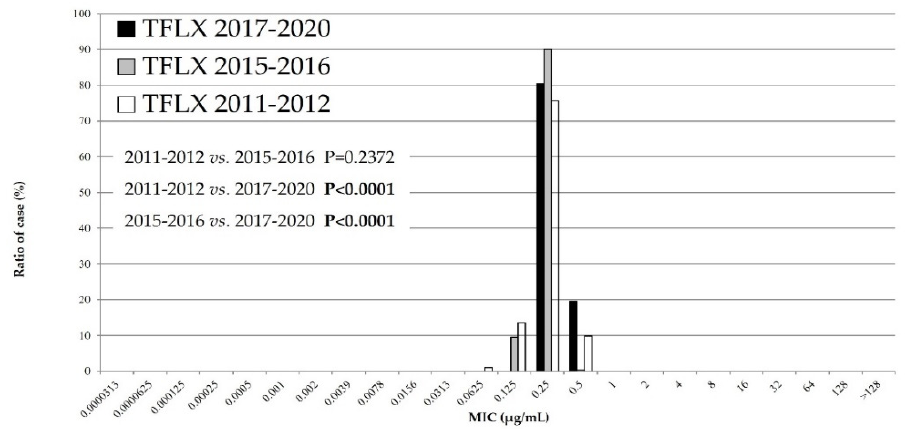
Figure 2. Minimum inhibitory concentration (MIC) distribution of tosufloxacin against Mycoplasma